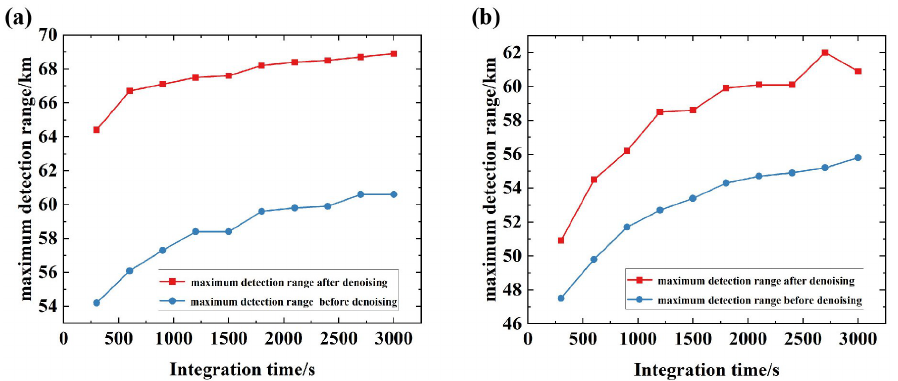
Figure 9. The variation of the maximum detection range with the integration time under the condition that ( a ) the error of density retrieval was less than 5% and ( b ) the error of temperature retrieval was less than 10 K.